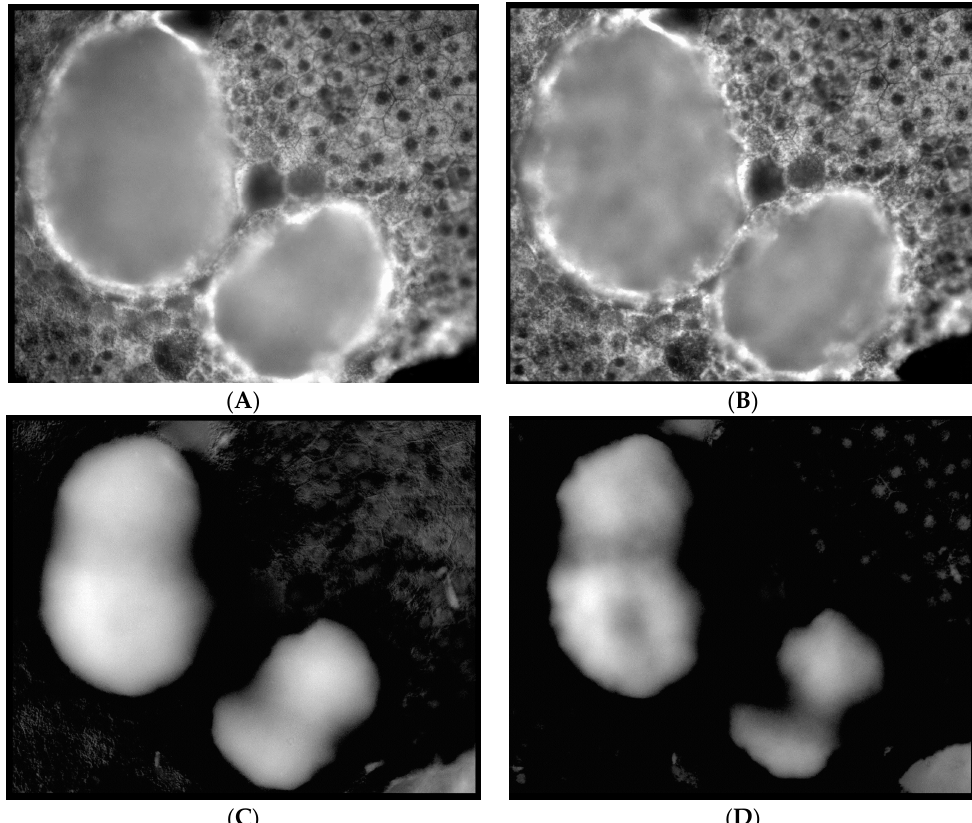
Figure 2. Comparison of abundance maps in an image with soft drusen achieved with two and three wavelengths of excitation. In these abundance maps, the brightness at each point is proportional to the strength of the emission of the given spectrum at that point. ( A , C ) Abundance maps achieved with two excitation wavelengths (436 nm and 480 nm, adapted from [14]). ( B , D ) Abundance maps achieved with three excitation wavelengths (436, 480 nm, and 505 nm). ( A , B ) Abundance maps of the retinal pigment epithelium (RPE) fluorophore spectrum S3 ( A ) and S2 ( B ). Note the high abundance of the RPE fluorophore source surrounding the dark nuclei in each cell. The distribution of fluorophore on the right may suggest attenuated RPE overlying the drusen. ( C , D ) Abundance maps of the drusen spectrum (SDr). The increased detail in the abundances of both RPE fluorophores and SDr obtained by going from two excitations (left) to three (right), is evident. More information is needed to discern among localizations in the Z ‐ axis of this projection image.